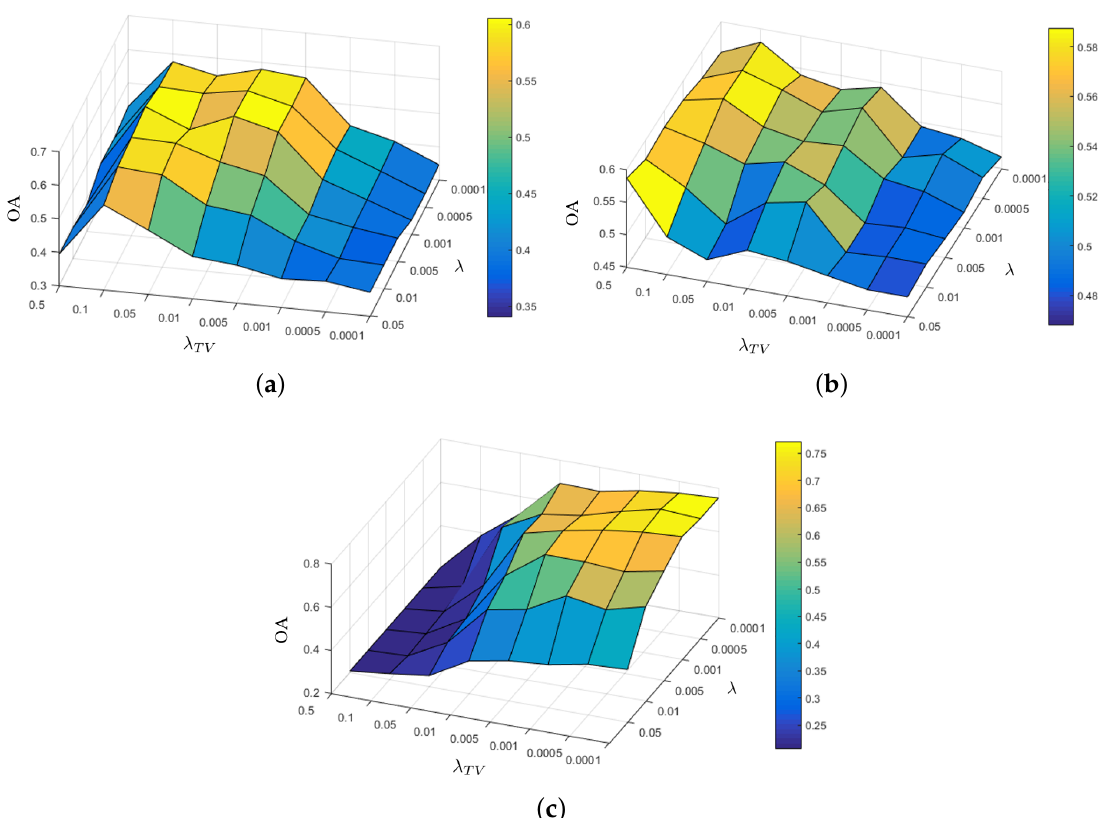
Figure 8. Grid search of λ and λ TV for Sketch-SSC-TV in three data sets: ( a ) Indian Pines ( b ) Pavia University ( c ) Salinas